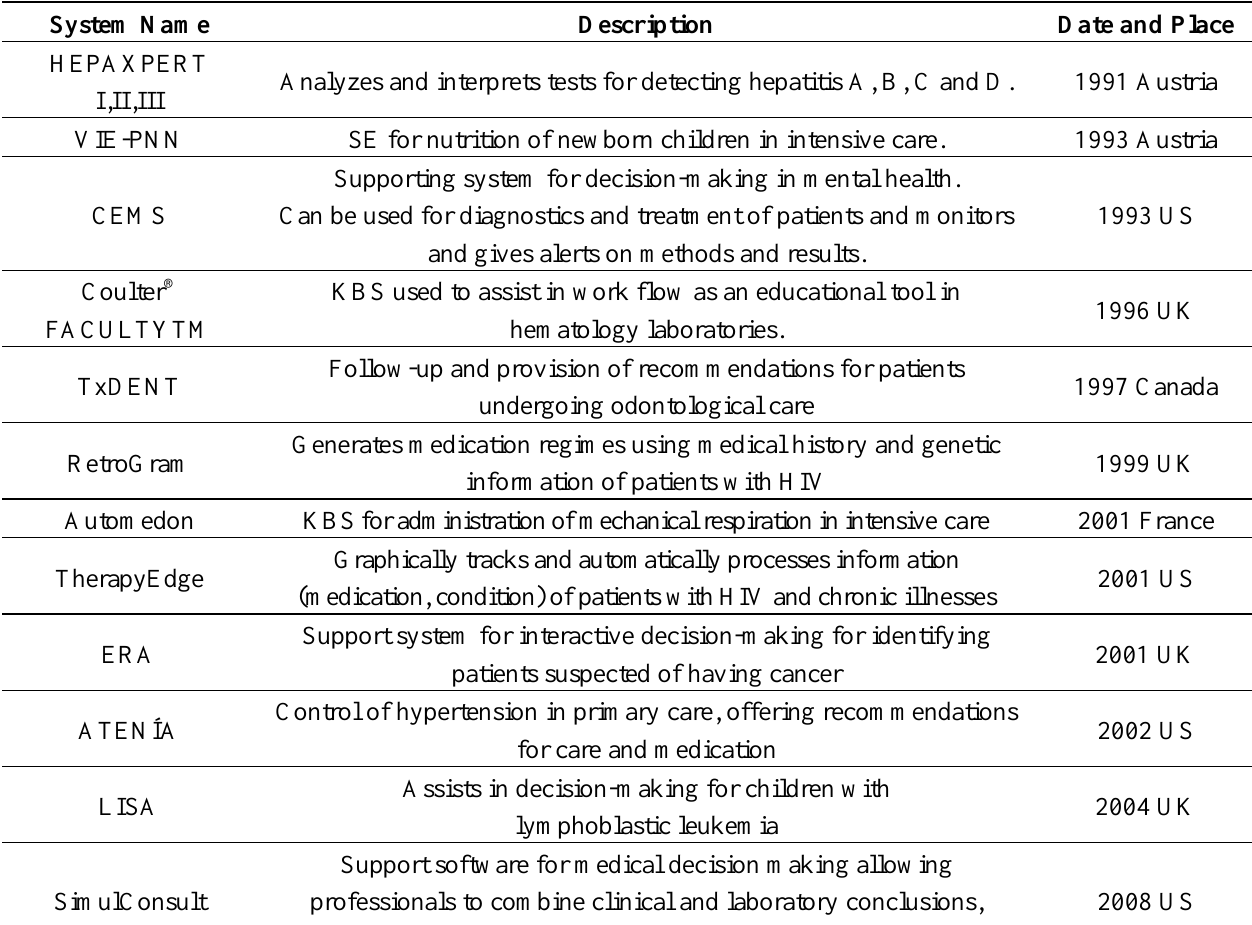
Table 1. Support systems for decision-making in